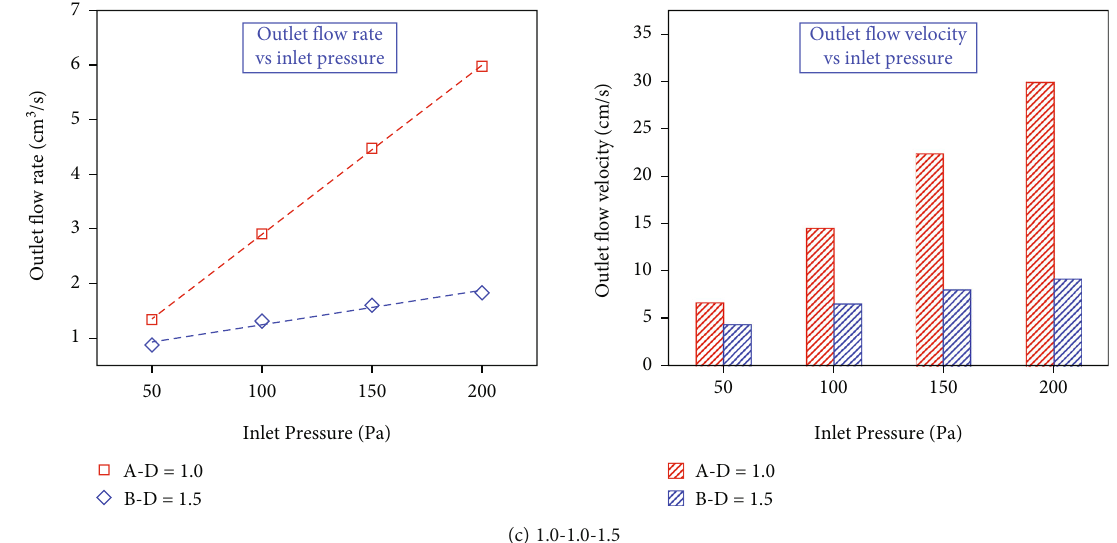
Figure 8: Evolution of fl ow and velocity with inlet pressure. Table 3: Fluid seepage results under di ff erent inlet pressures. Fracture